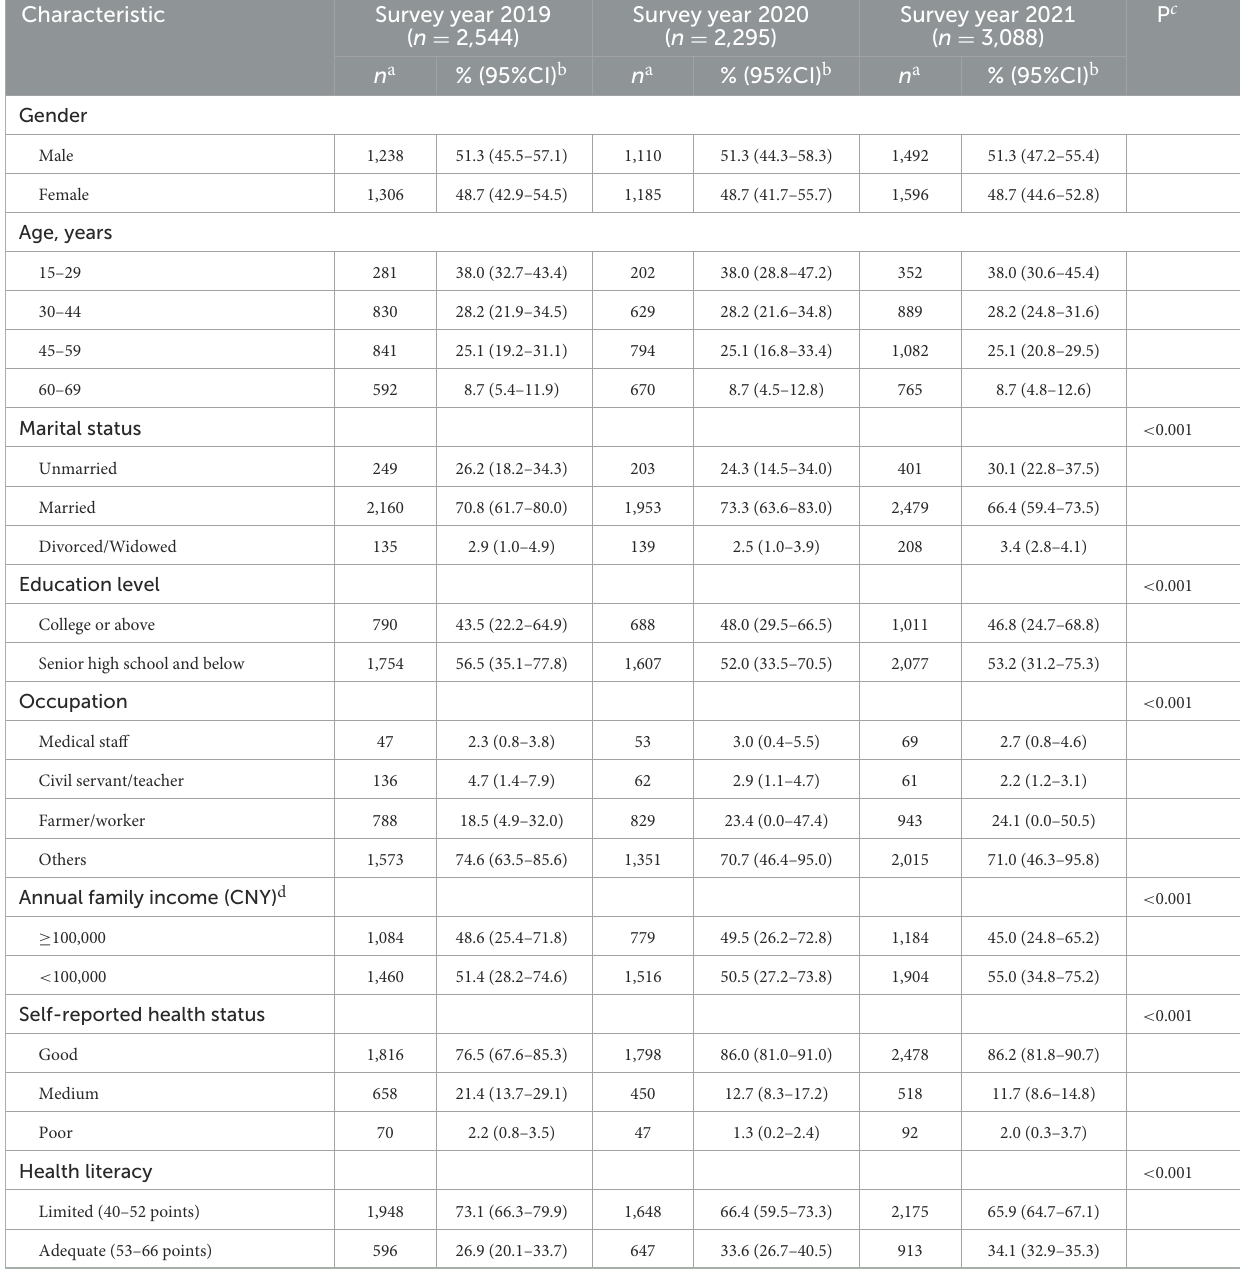
TABLE 1 Descriptive statistics of the study population over time ( n =